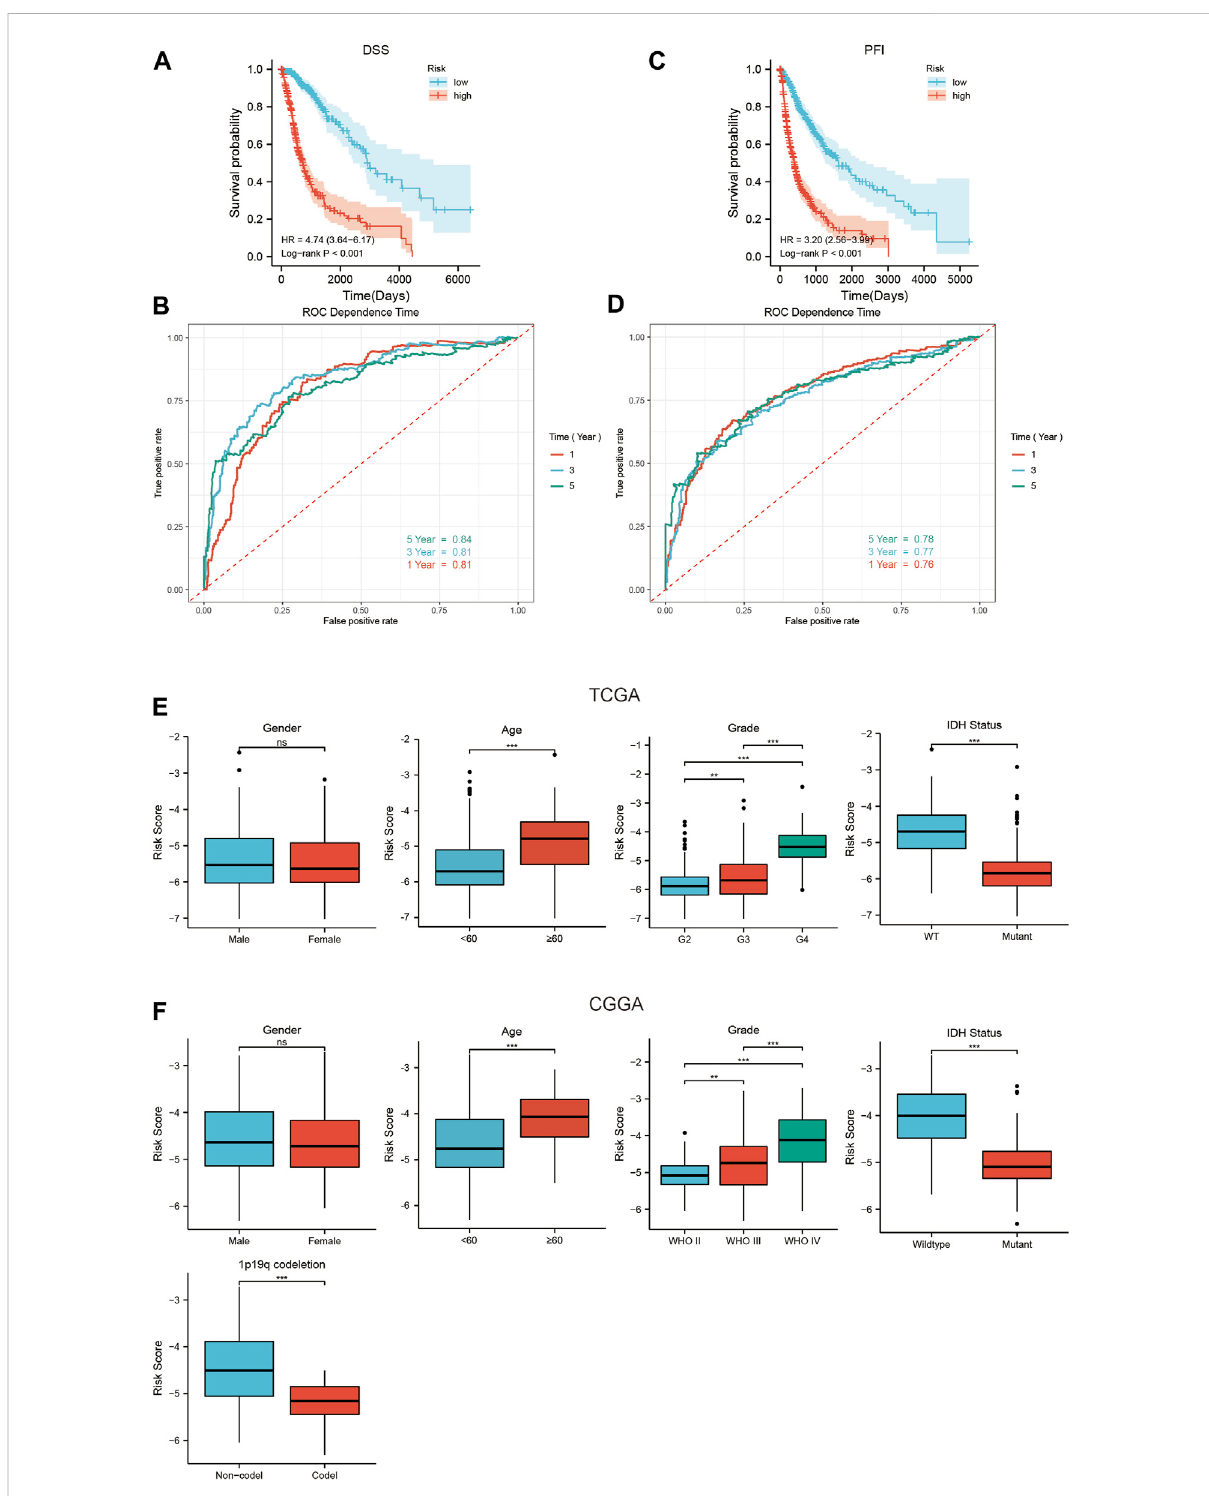
FIGURE 6 The relationship between the SIRT-Based signature and DSS, PFI, and clinical characteristics of glioma patients. (A) The SIRT-based signature predicts the Kaplan – Meier survival of DSS in the TCGA queue. (B) The SIRT-based signature predicts the time-dependent ROC curves of 1-, 3-, and 5-year DSS of glioma patients in the TCGA database. (C) The SIRT-Based signature predicts the Kaplan-Meier survival of PFI in the TCGA queue. (D) The SIRT-based signature predicts the time-dependent ROC curves of 1-, 3-, and 5-year PFI of glioma patients in the TCGA database. (E) Relationship between SIRT-Based signature and sex, age, pathological grade, and IDH status of glioma patients in TCGA database. (F) Relationship betweentheSIRT-basedsignatureandsex,age,pathologicalgrade,IDHstatus,and1p19qco-deletionofgliomapatientsintheCGGAdatabase(* p < 0.05, ** p < 0.01, *** p < 0.001, ns: p >